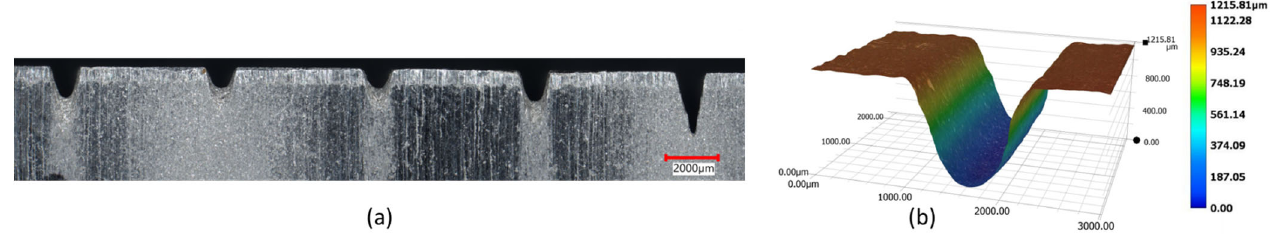
Table 2. Experimental parameters.